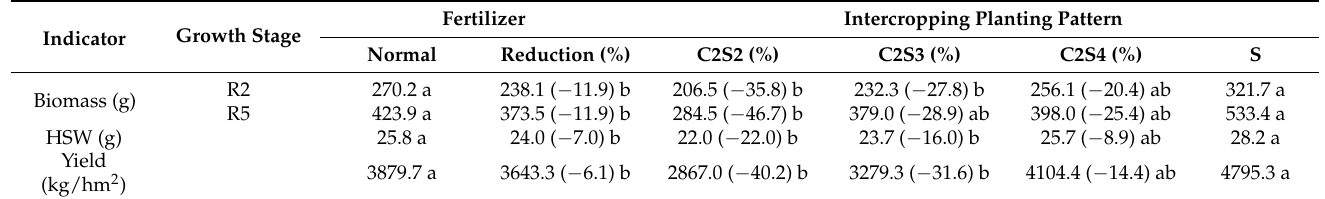
Table 2. Mean biomass per plant (g), 100-seed weight (g) and yield (kg/hm 2 ) of soybean with normal and reduces fertilizer levels in four intercropping planting